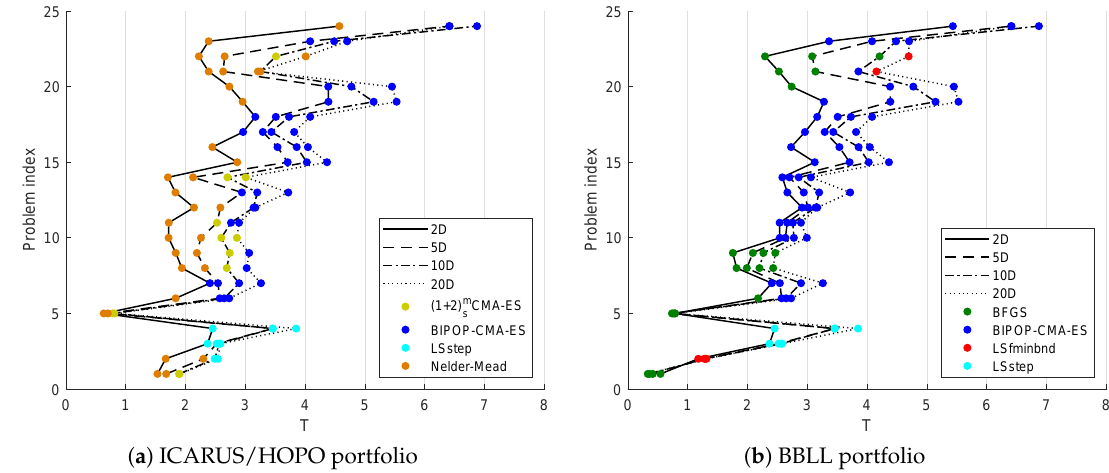
Figure 5. Performance of the best algorithm in terms of (cid:98) T for each problem. The lines represent the dimension of the problem. The Nelder–Doerr algorithm replaces BFGS in the ICARUS/HOPO portfolio in most of the